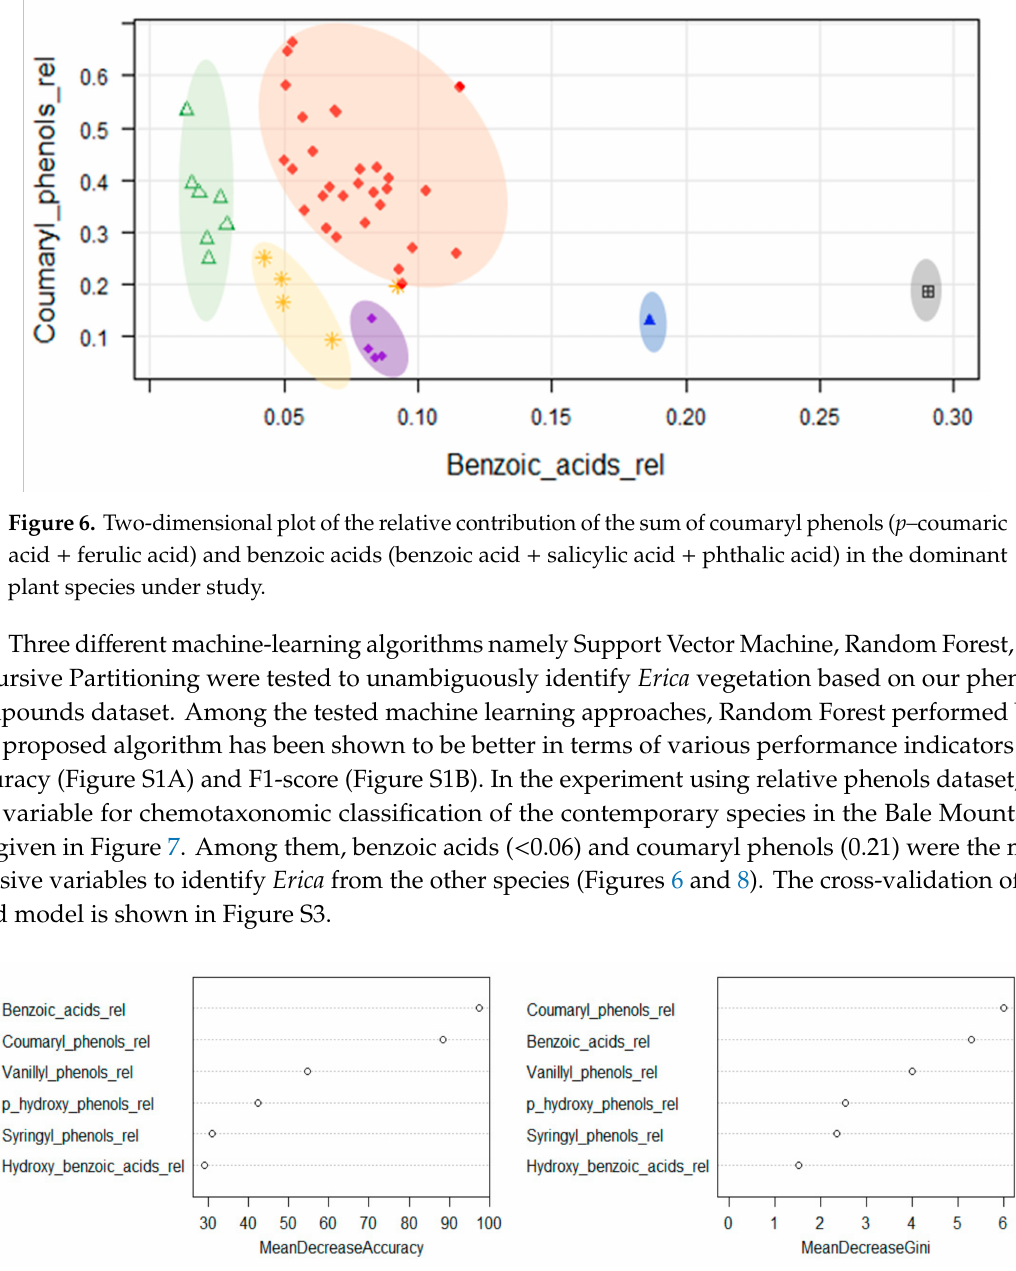
Figure 7. Set of relative phenols variables used for chemotaxonomy ordered by their importance as estimated by the Random Forest model. 32 training sample sets and 10.000 number of trees were used to compute the